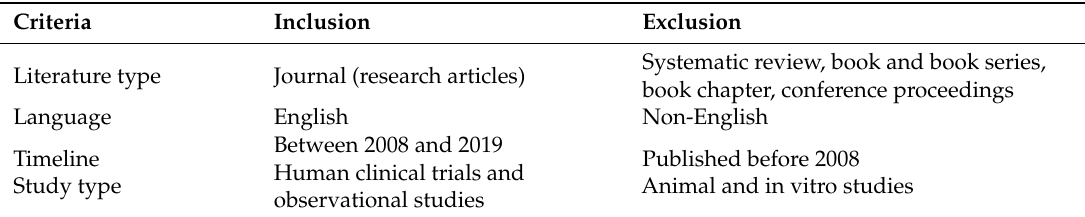
Table 1. Inclusion and exclusion